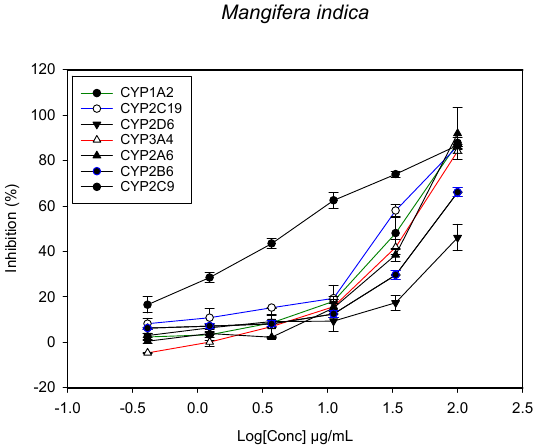
Figure 4. The inhibitory effect of graded concentrations of the extracts of M. indica on the metabolic activity of cytochrome P450 enzymes.